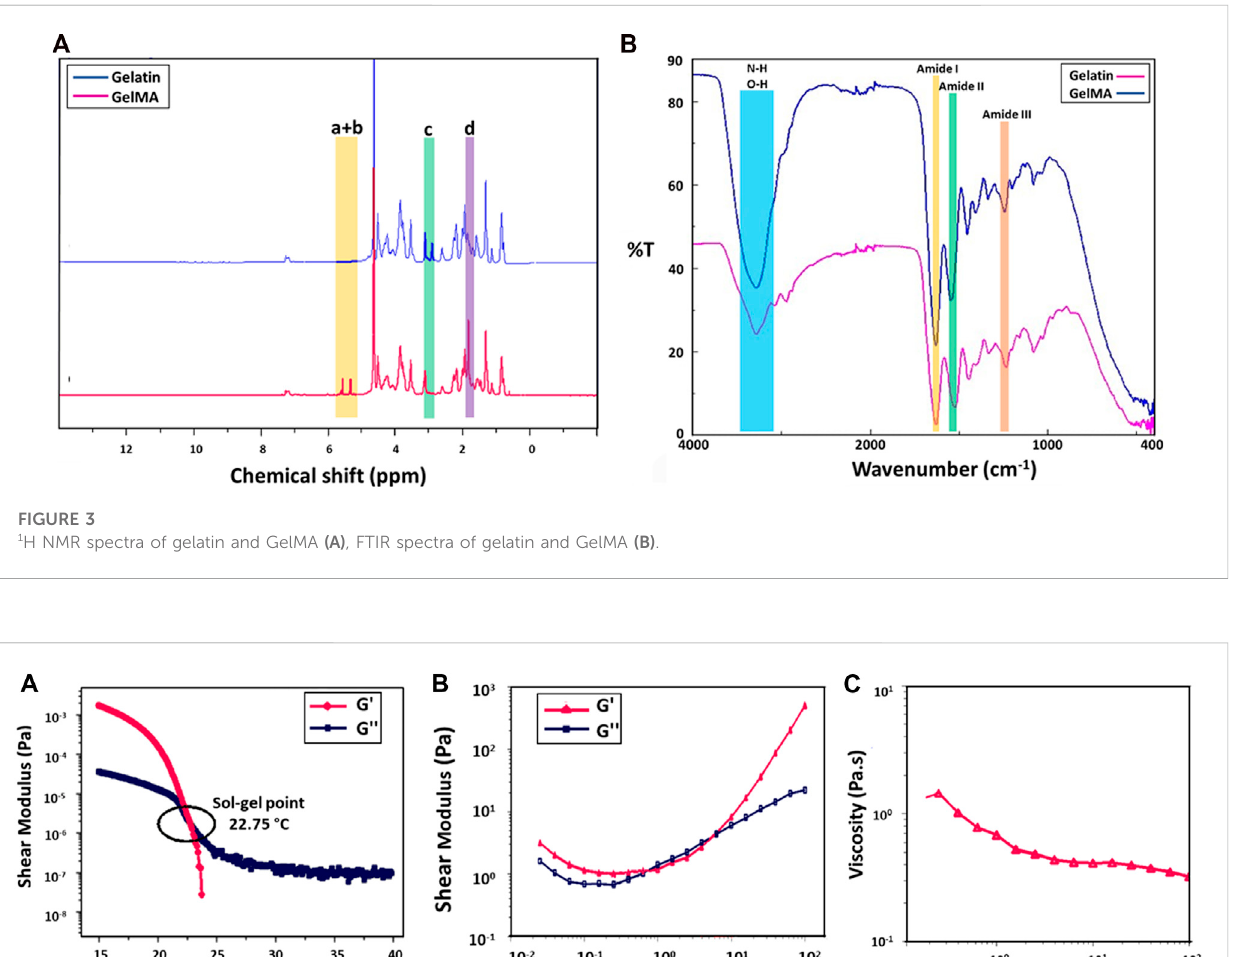
FIGURE 4 Rheological analysis of 10% (w/v) GelMA hydrogel, (A) temperature ramp test, (B) frequency sweep test, and (C) rotational shear rate-viscosity measurement.